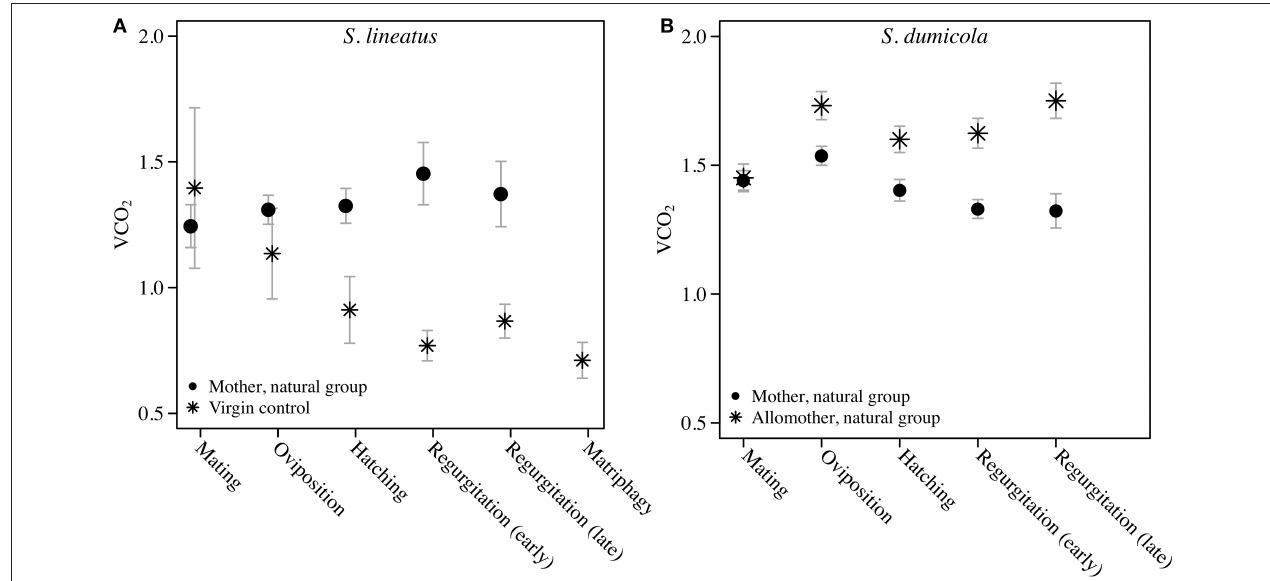
FIGURE 2 | Data on Standard Metabolic Rate measured as VCO 2 ( µ L CO 2 /minute/gram) during the natural brood care period (natural group) in mothers and virgin control females of the solitary spider S. lineatus (A) , and in mothers and allomothers (non-reproducing helpers) of the cooperative spider S. dumicola (B) . For each measurement of mothers, simultaneous measurements were performed on virgin controls ( S. lineatus ) or allomother females ( S. dumicola ). The mothers succumbed to matriphagy and were thus not measured at this stage. The VCO 2 measure provided is the average of the 3 lowest measurements out of 40. Error bars show the standard error of the